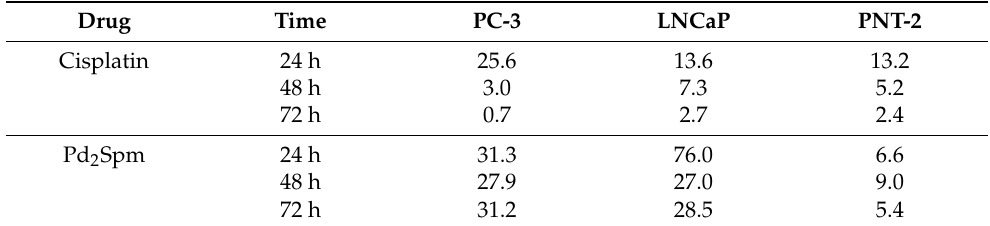
Figure 2. Dose–response curves of cisplatin and Pd 2 Spm against prostate cancer (PC-3, red line; LNCaP, blue line) and prostate non-cancer (PNT-2, black line) cell lines, at 24, 48, and 72 h incubation times. Data are expressed as mean ± SEM, n = 4. Table 1. Half maximal inhibitory concentration (IC 50 , µM) of cisplatin and Pd 2 Spm against prostate cancer (PC-3 and LNCaP) and prostate non-cancer (PNT-2) cell lines, at 24, 48, and 72 h incubation times.